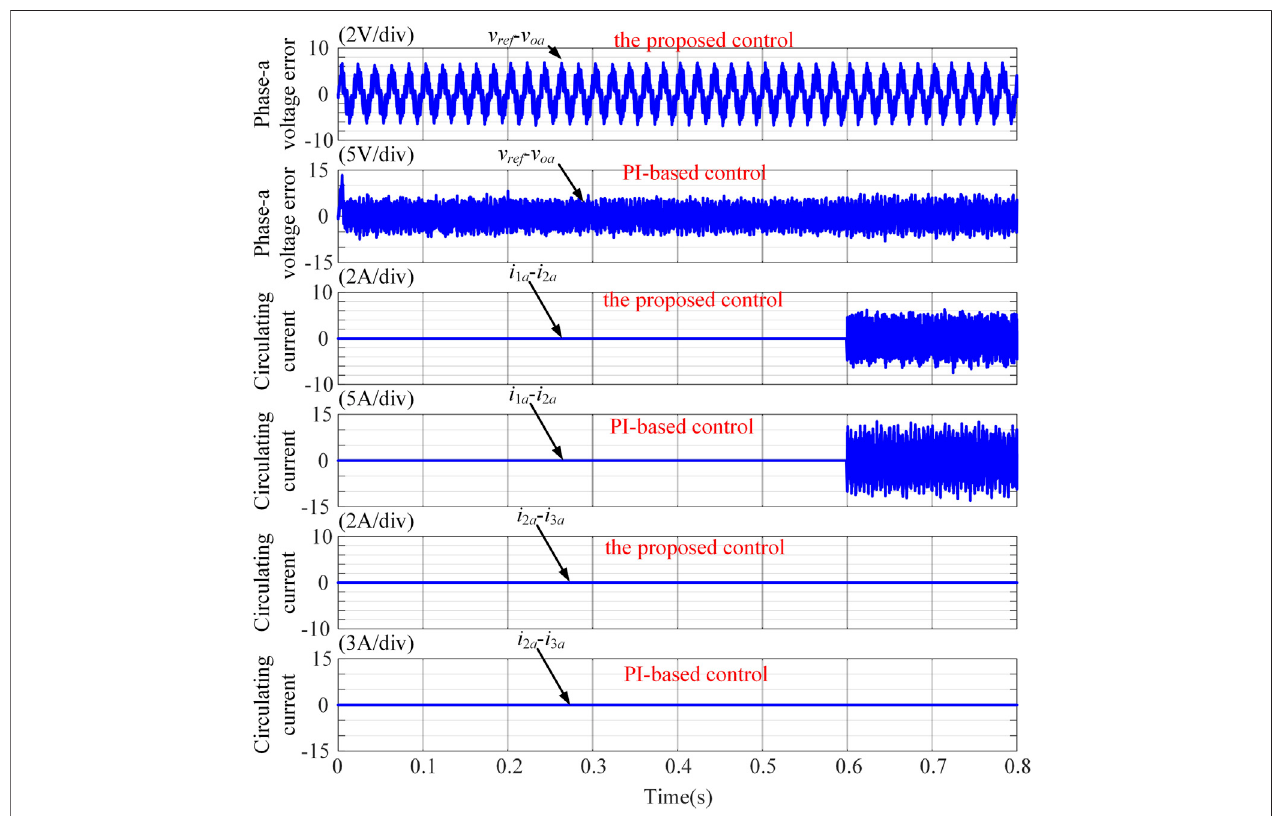
FIGURE 9 | Simulation waveforms of phase-a voltage tracking error and circulating currents under linear load condition.